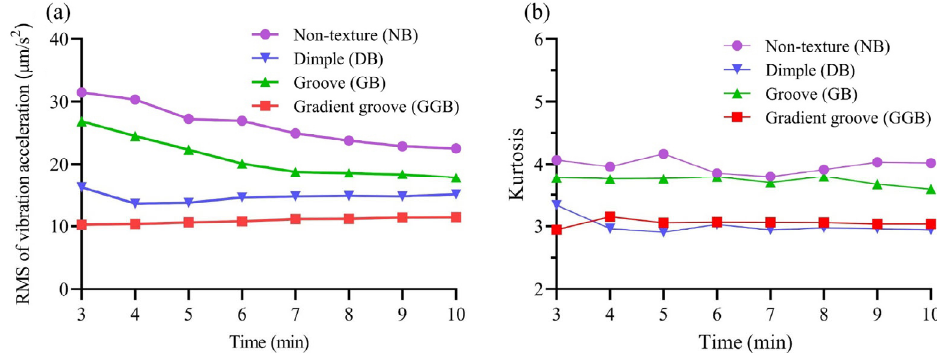
Fig. 10 RMS value and kurtosis of vibration acceleration of four